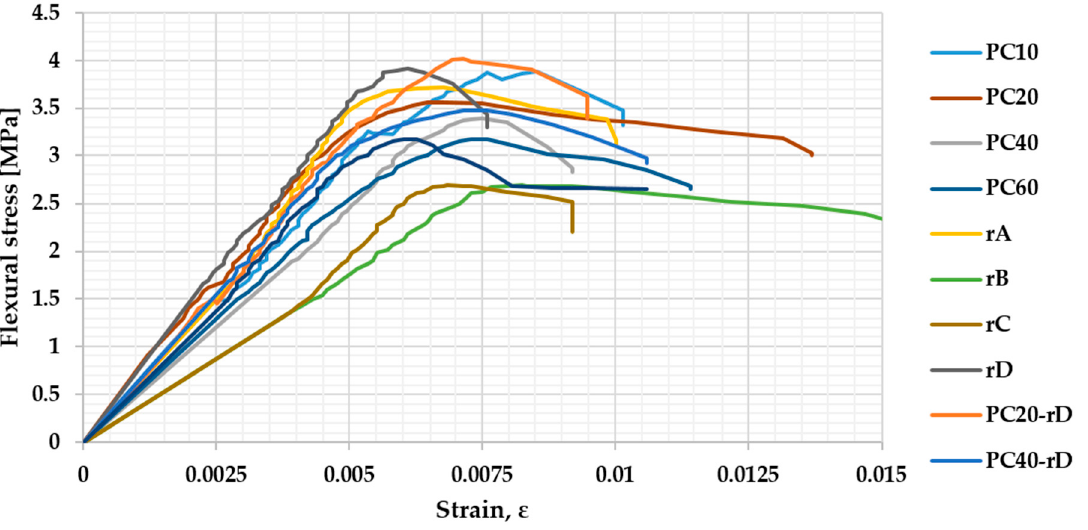
Figure 9. Stress–strain plots.